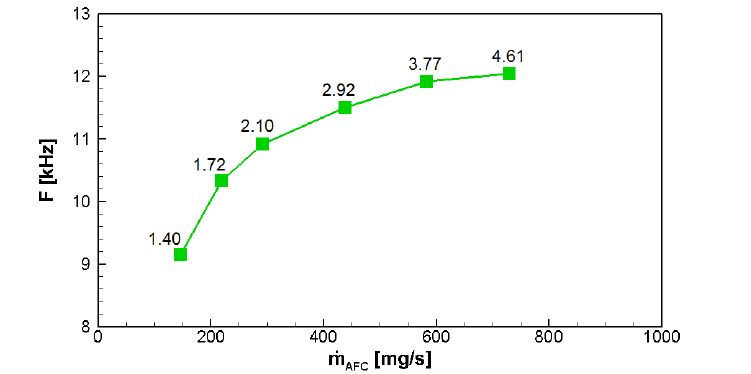
Figure 5. Actuation frequency over mass flow rate for Re 1 =